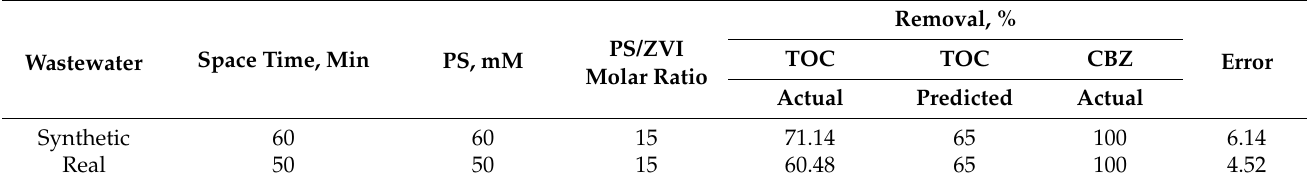
Table 3. RSM optimal conditions and experimental verification for TOC